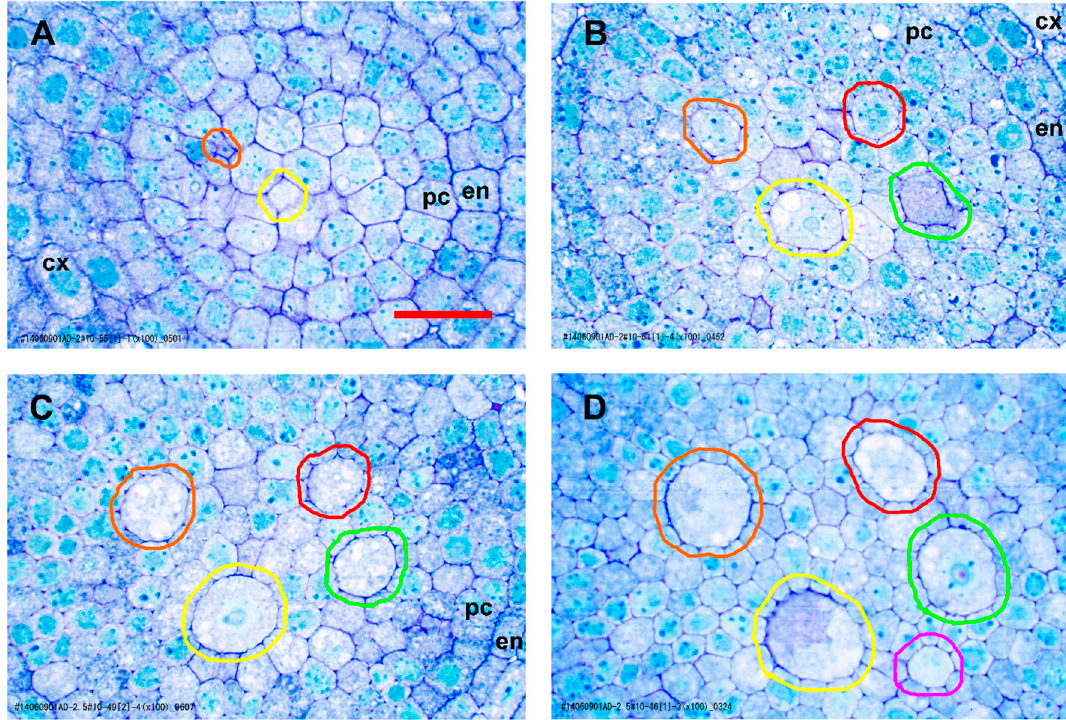
Figure 3. Normal LMX and first early metaxylem (EMX) development revealed by representative transverse sections from among ca. 600 serial sections taken from one teosinte primary root. The micrographs are centered on the stele. ( A ) Appearance of first (encircled yellow) and second (orange) LMX (38 µ m from the rootcap junction [RCJ]). ( B ) All four LMX present (78 µ m from RCJ); third (green), fourth (red). ( C ) 110 µ m from RCJ. ( D ) First EMX (magenta) appeared by 204 µ m from RCJ. EMX, early metaxylem; LMX, late metaxylem vessel; cx, cortex; en, endodermis; pc, pericycle. Scale bar = 25 µm.